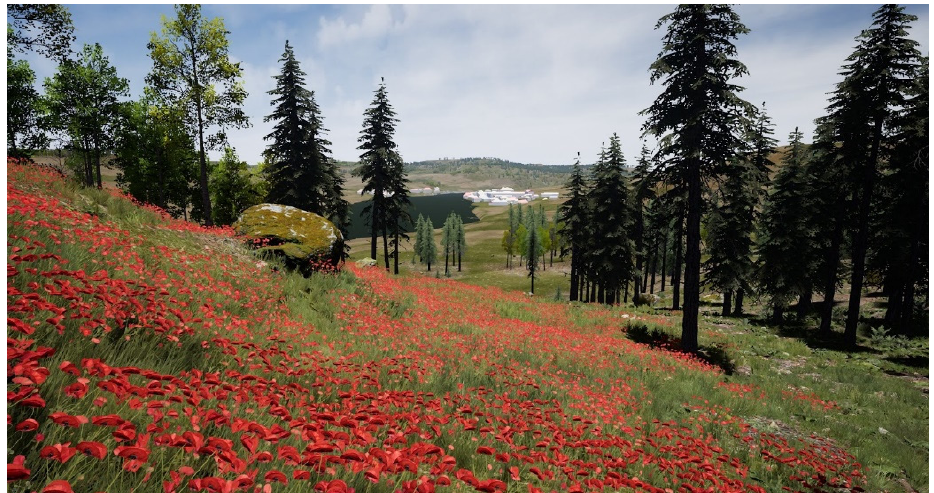
Figure 12. Close-up on the vegetation in a virtual reality